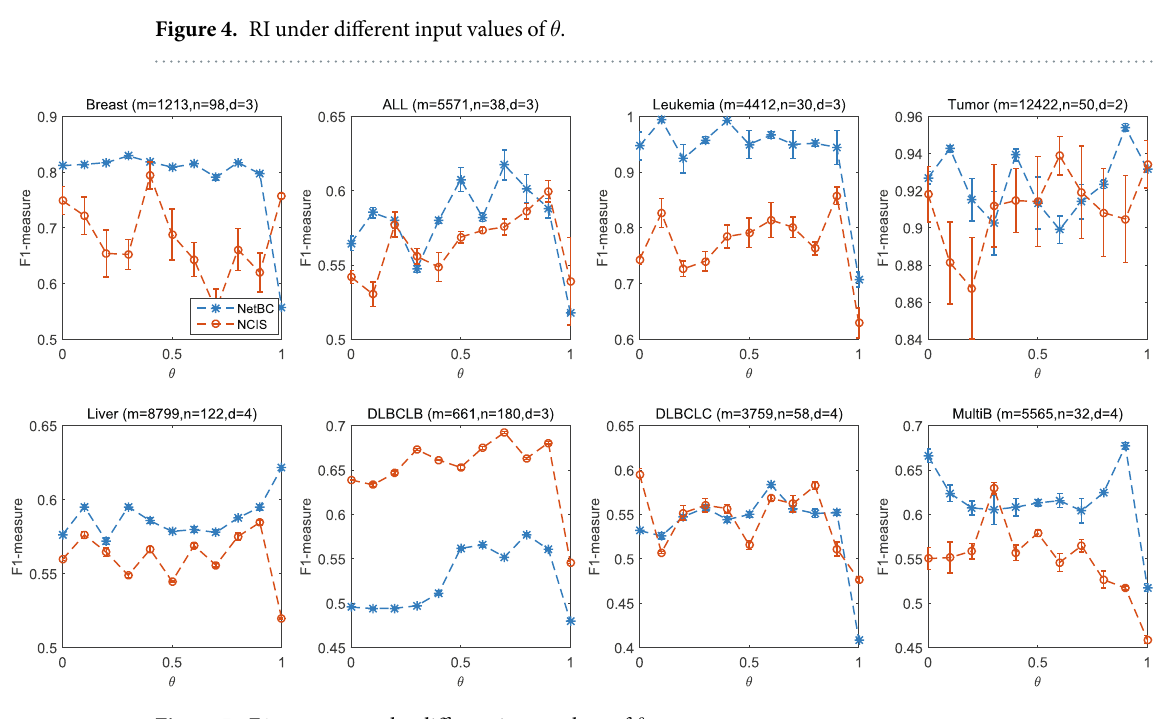
Figure 5. F1-measure under different input values of θ